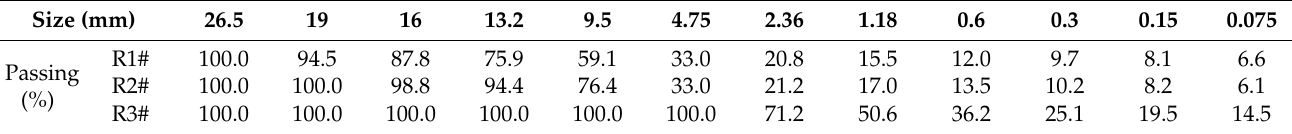
Table 2. The gradation of RAPs after extraction.